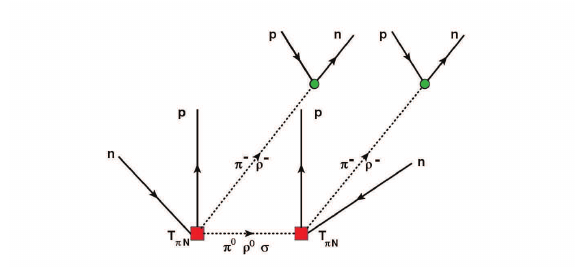
Figure 2. Generic diagram illustrating the hadronic surrogate process for 0 ν 2 β decay. A virtual nn cess, causing the ∆ Z = + 2 target transition A nied by nnp − 1 p − 1 double-CC excitation in the projectile. Crossed diagrams are not